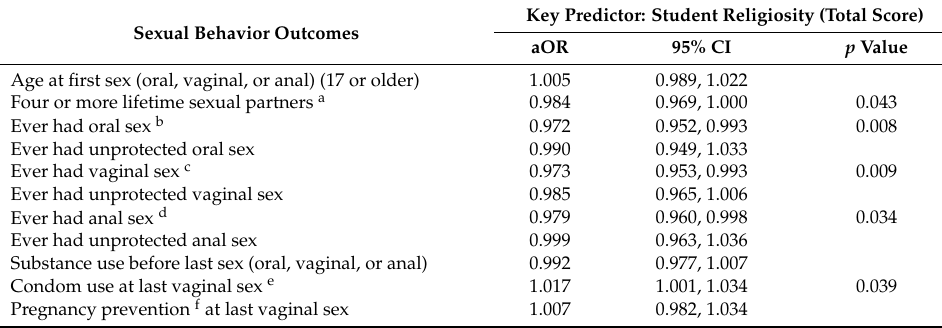
Table 6. Binary logistic regression models predicting emerging adults’ sexual behaviors. Key Predictor: Student Religiosity (Total Score) Sexual Behavior Outcomes aOR 95% CI p Value Age at first sex (oral, vaginal, or anal) (17 or older)